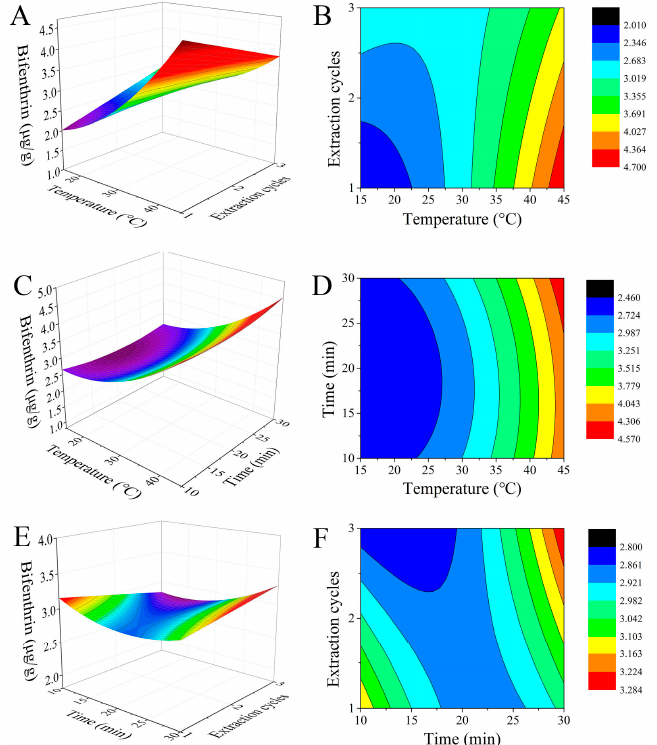
Figure 1. Response surface plots ( A , C and E ) and contour plots ( B , D and F ) of bifenthrin extract content affected by temperature, extract time and extraction cycles.